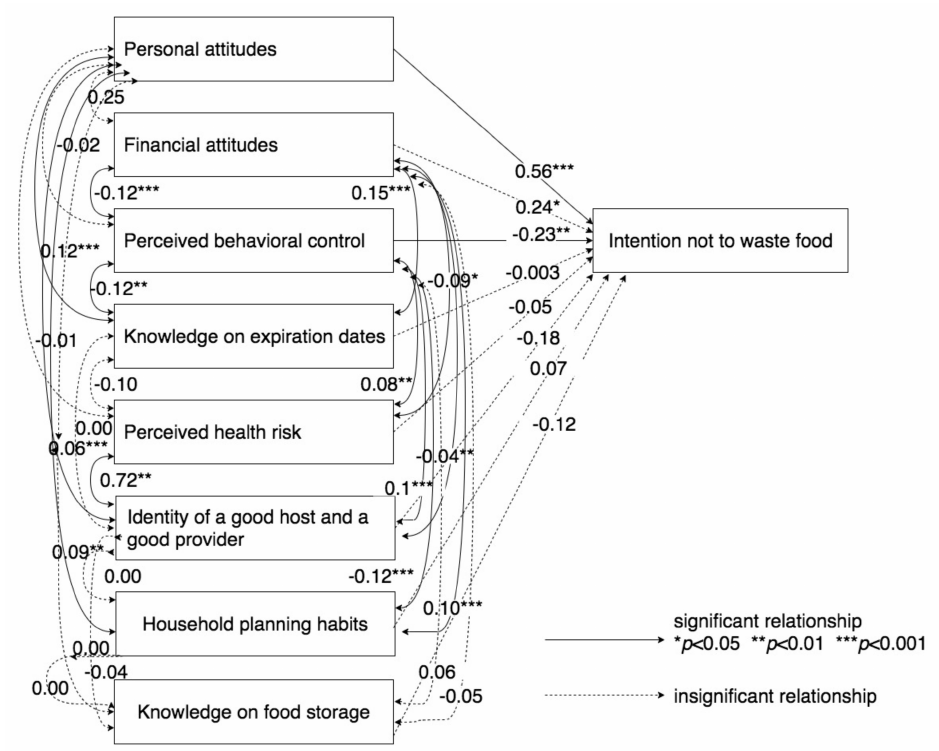
Figure 3. TPB model for segment 1. Full lines mean significant relationship; dotted lines mean insignificant relationship; * p < 0.05; ** p < 0.01; *** p <